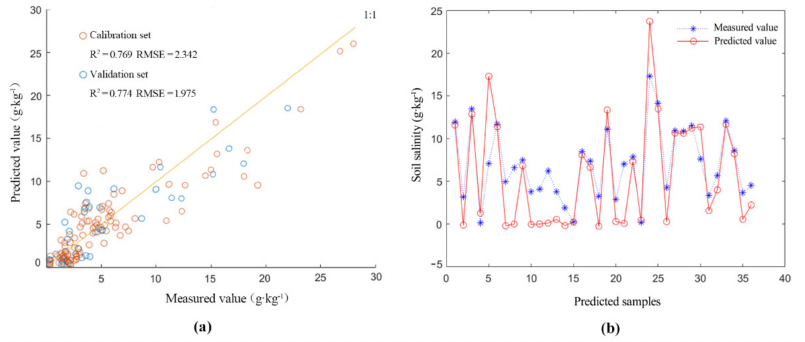
Figure 6. ( a ) Scatter plot for accuracy verification based on the best estimation model of soil salinity according to UAV multispectral imagery. ( b ) Comparison of the prediction results of soil salinity in the validation